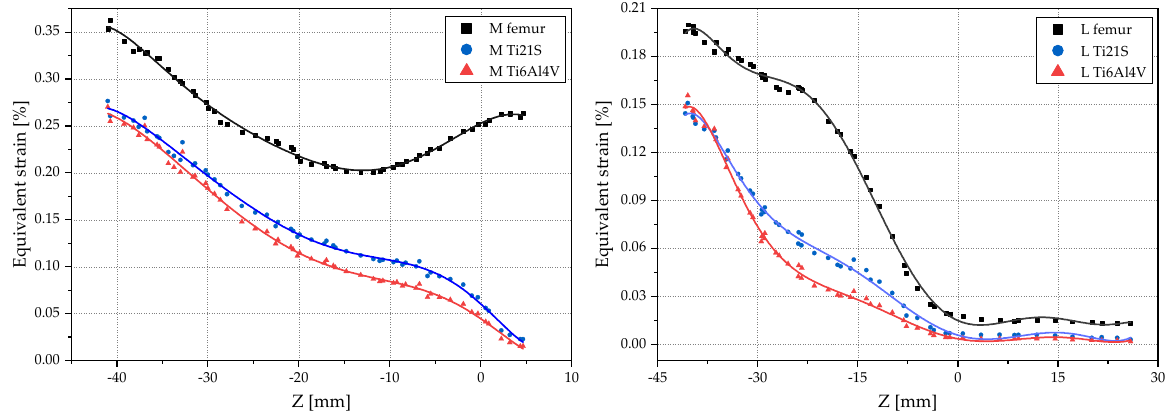
Figure 19. Scatter plots of the equivalent strain of GC2 in the medial and lateral sides.